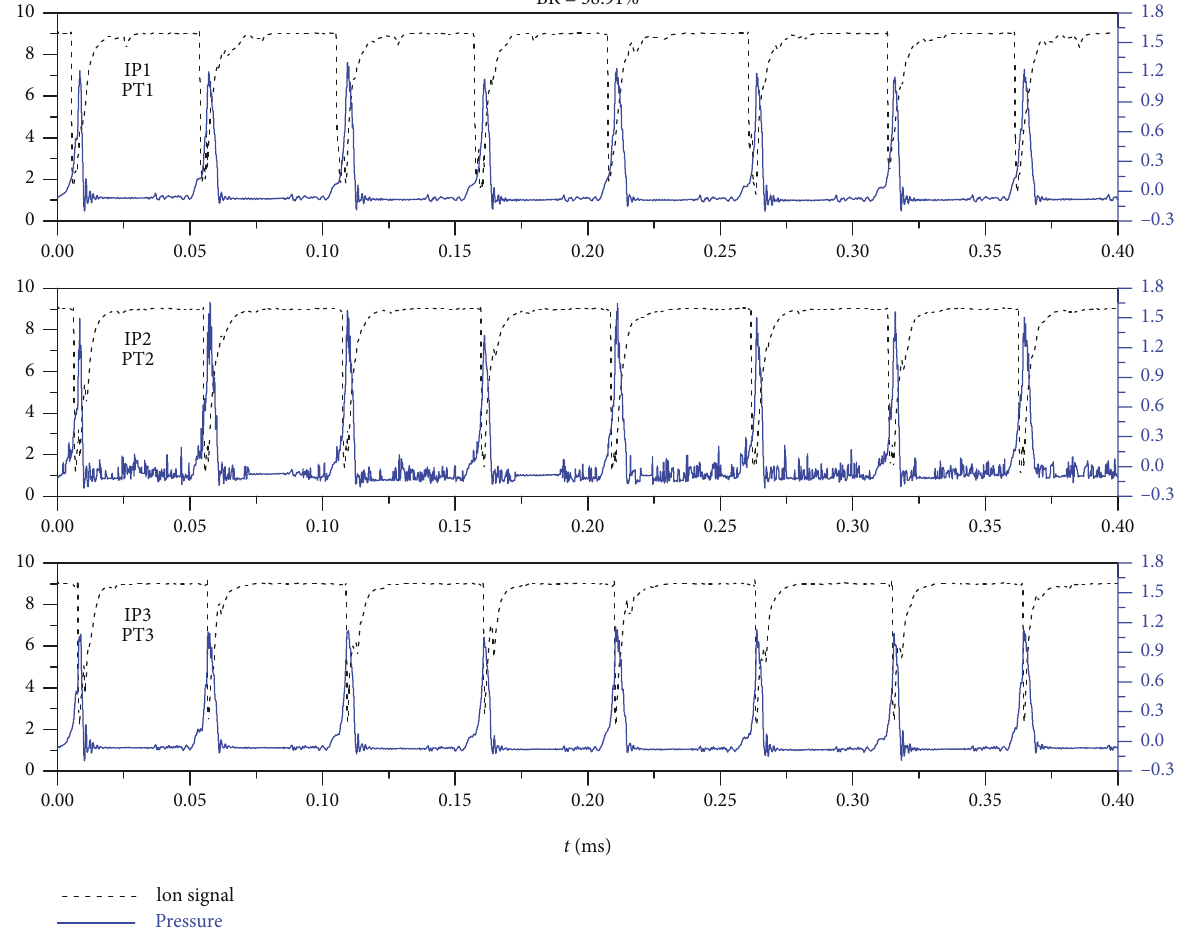
Figure 8: Signals collected by the ion probe and pressure